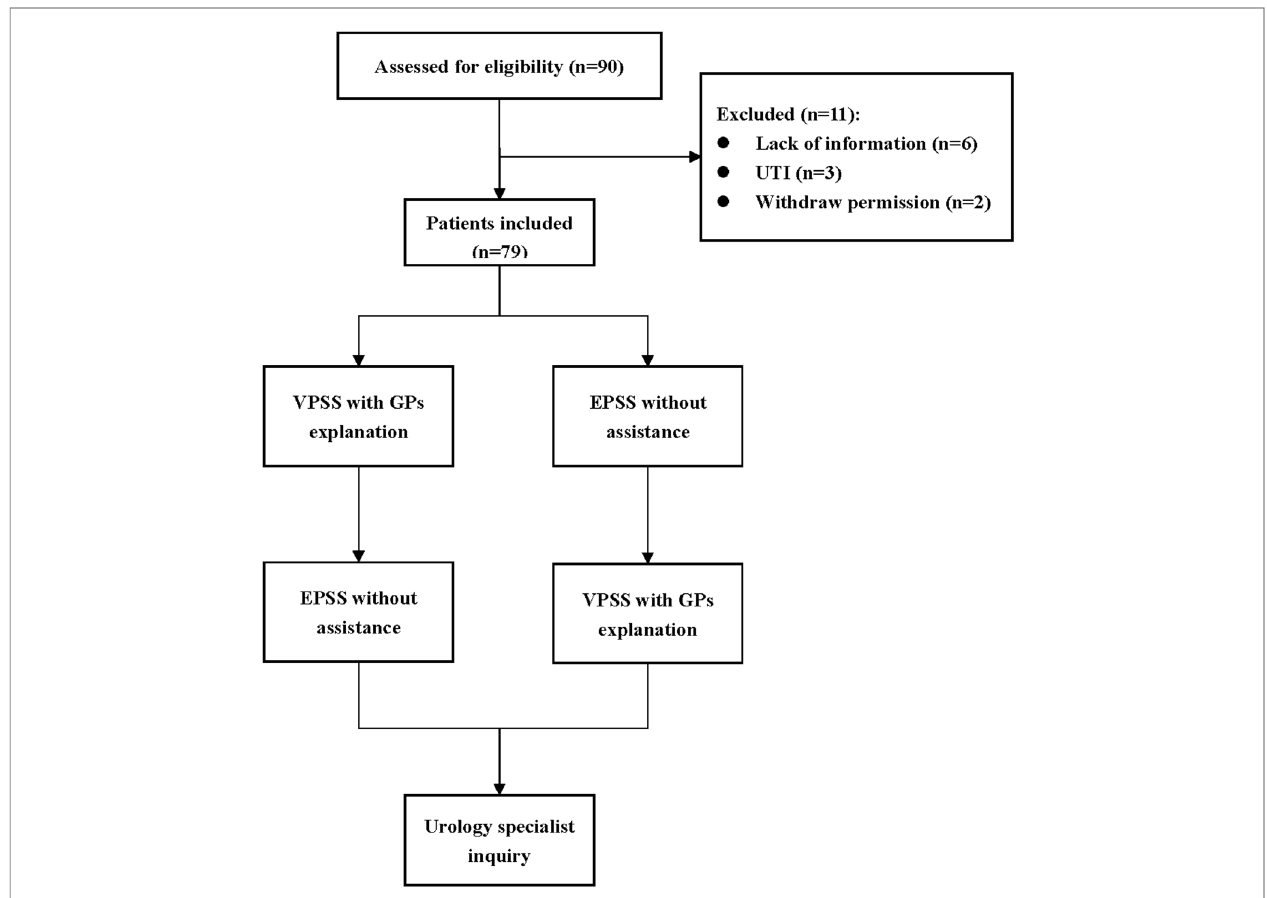
FIGURE 1 | Protocol. A total of 90 patients were recruited, and 79 patients were fi nally included. We randomize the order of the two versions of the scale for each patient to minimize the potential